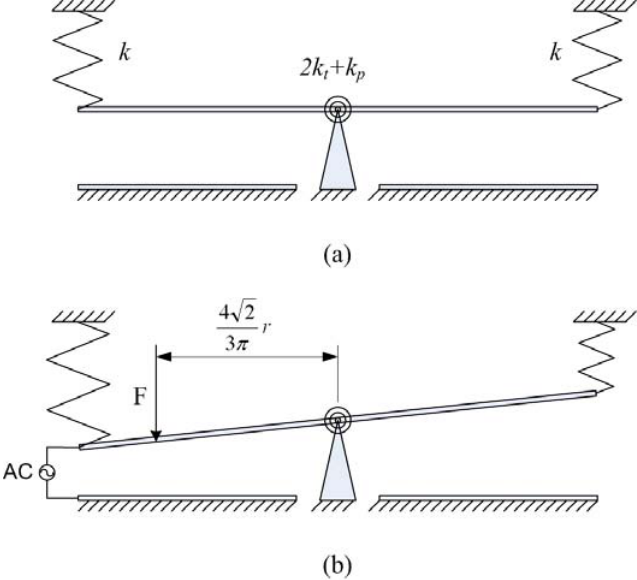
Figure 2. Dynamic model of a micromirror operated in the (a) absence and (b) presence of a driving